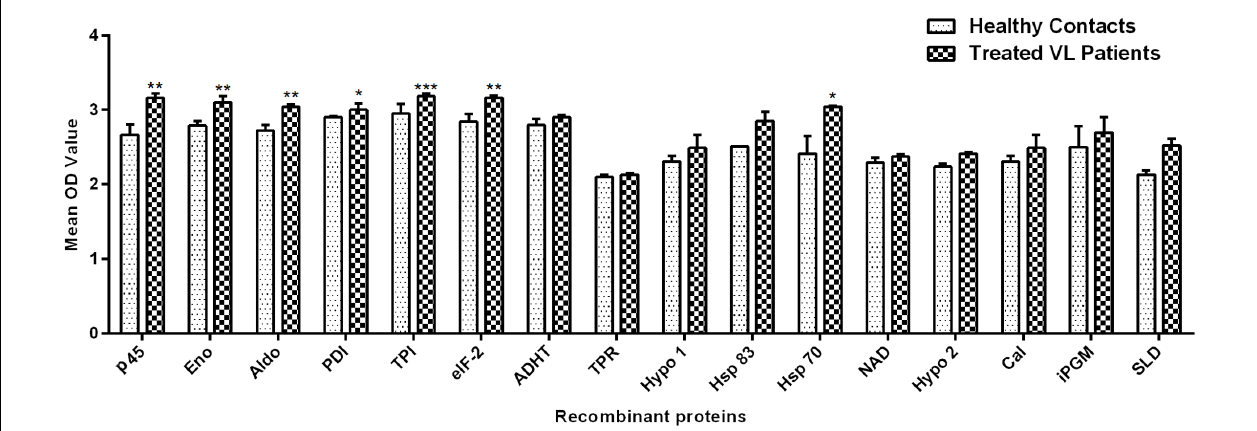
FIGURE 2 | Lymphoproliferative response in PBMCs of treated VL patients in response to 15 recombinant proteins and SLD (10 µ g/ml each). Each bar represents the pooled data (mean ± SE). Significance values indicate the difference in stimulation between the SLD and the recombinant proteins ( ∗ p < 0.05, ∗∗ p < 0.01, and ∗∗∗ p < 0.001). TABLE 3 | Cytokine levels in recombinant proteins and SLD stimulated PBMCs from treated VL patients (T) and healthy contacts (HC). S. No.